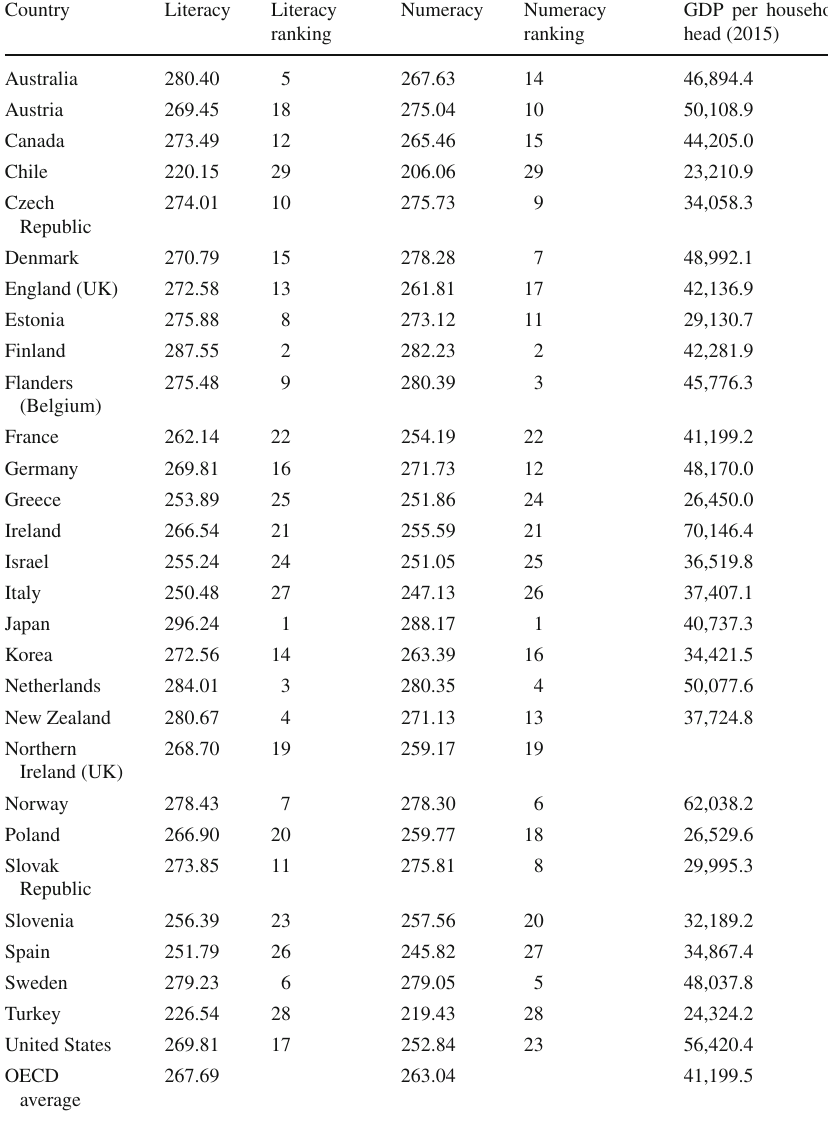
Table 1 Performance in literacy and numeracy. Source : Columns 2–5, OECD (2016, Figure 1.1.); column 6, http://stats.oecd.org, the level evel of GDP per capita and